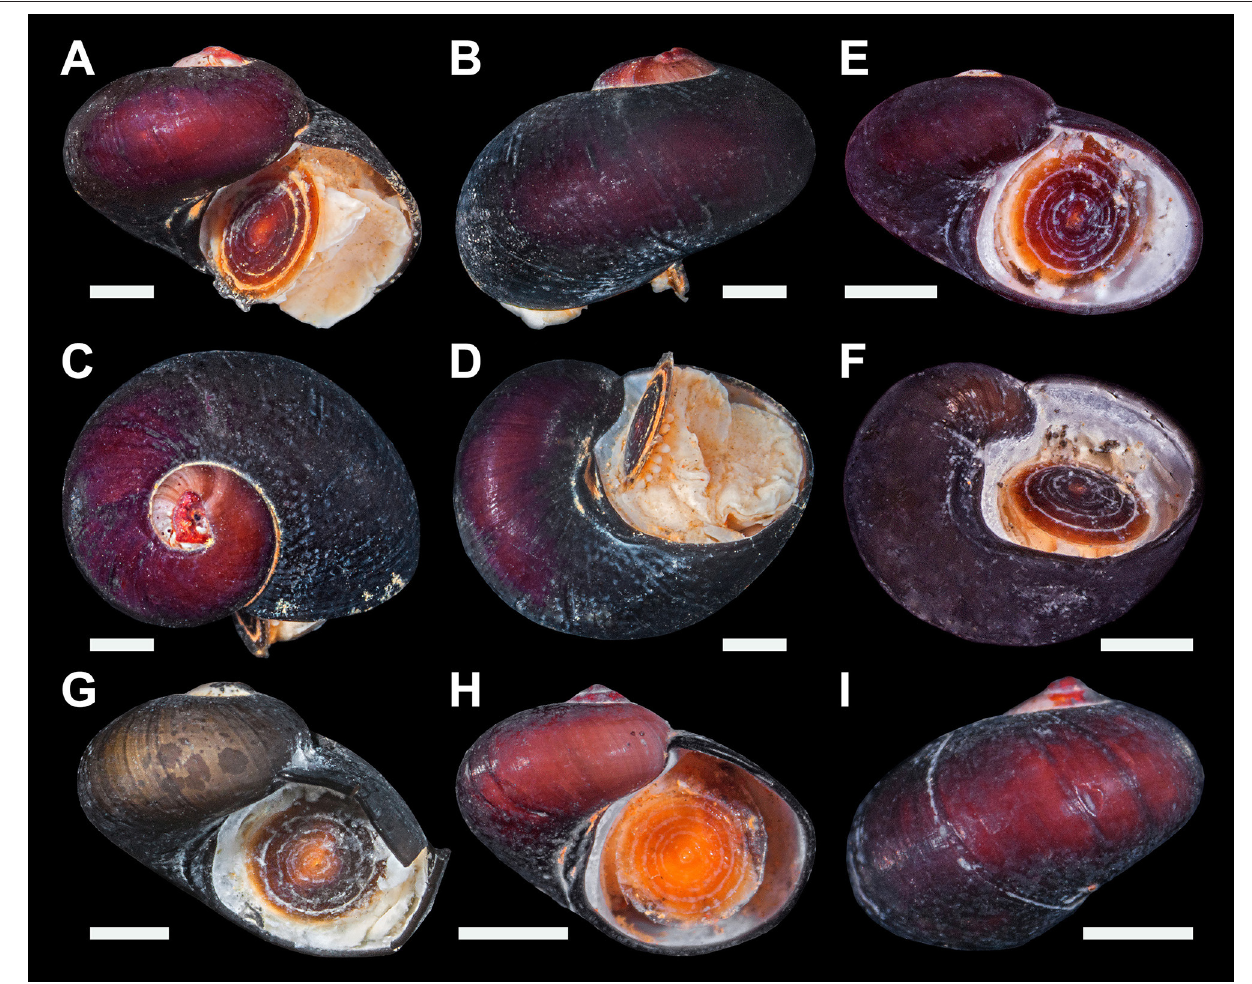
FIGURE 5 | Dracogyra subfuscus n. gen. n. sp., type specimens. (A–D) Holotype (NHMUK 20170386). (E–F) Paratype 1 (SMNH Type-8950). (G) Paratype 2 (UMUT RM32667). (H–I) Paratype 3 (SIOSOA RSIO35616). All scale bars =